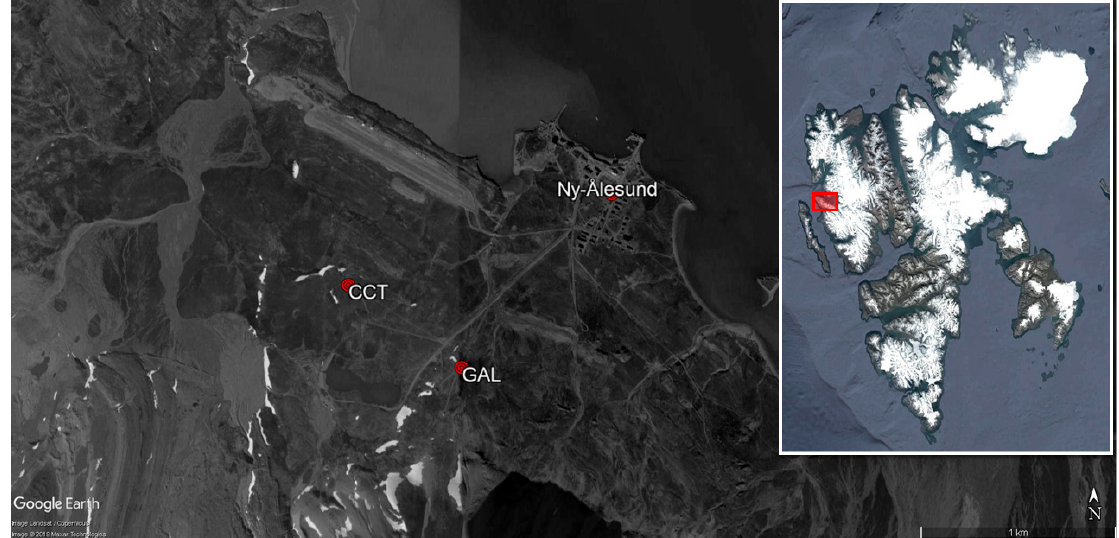
Figure 1. Map of the sampling area. The red marks indicate the location of the Climate Change Tower (CCT), the Gruvebadet Atmospheric Laboratory (GAL), and the Ny-Ålesund research village. The inset shows the Svalbard archipelago with a red rectangle highlighting the Brogger peninsula and the Kongsfjorden where the sampling stations are located.